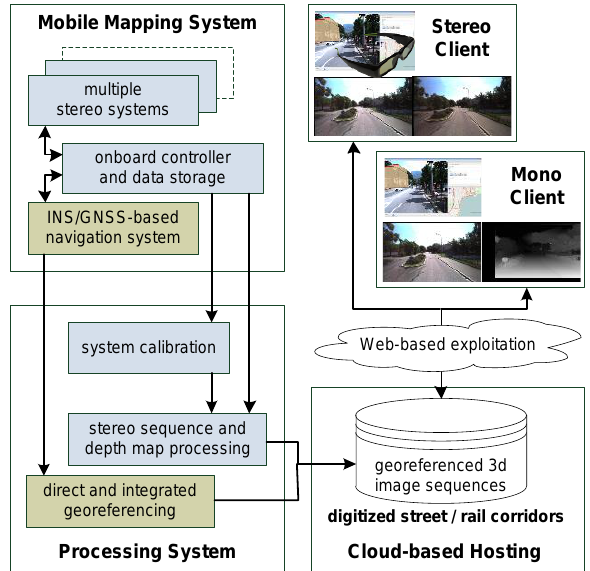
Figure 3. Stereovision processing pipeline and workflow for the mobile ground-based multi-stereo imagery The introduced stereovision based mobile mapping enables absolute 3d point accuracy of 3-4 cm (1 sigma) under average GNSS conditions (Burkhard et al., 2012). Relative measure- ments within a single stereo frame or between points in neighbouring frames of the image sequence are better than 1cm.